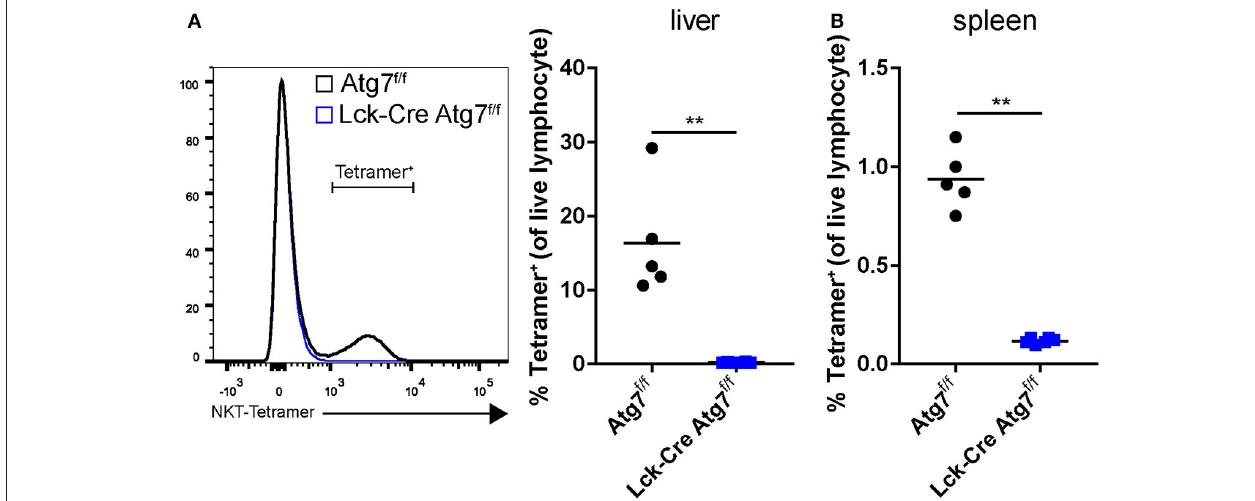
FIGURE 4 | Atg7 deficiency in T cells reduces the amount of NKT cells in liver and spleen. (A) NKT cells as detected by an α -GalCer/CDld tetramer staining and presented as a percentage of the lymphocyte fraction in the liver. (B) Percentage ofNKT cells in spleen. ** p < 0.01.